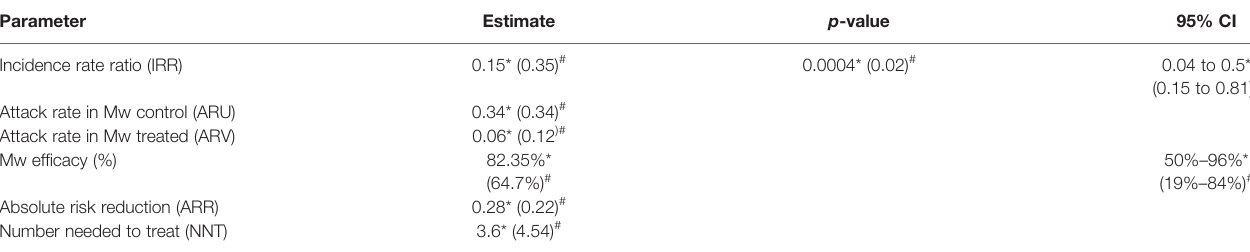
TABLE 2 | Incidence rate ratio of SARS-CoV-2 infections and Mw ef fi cacy. Parameter